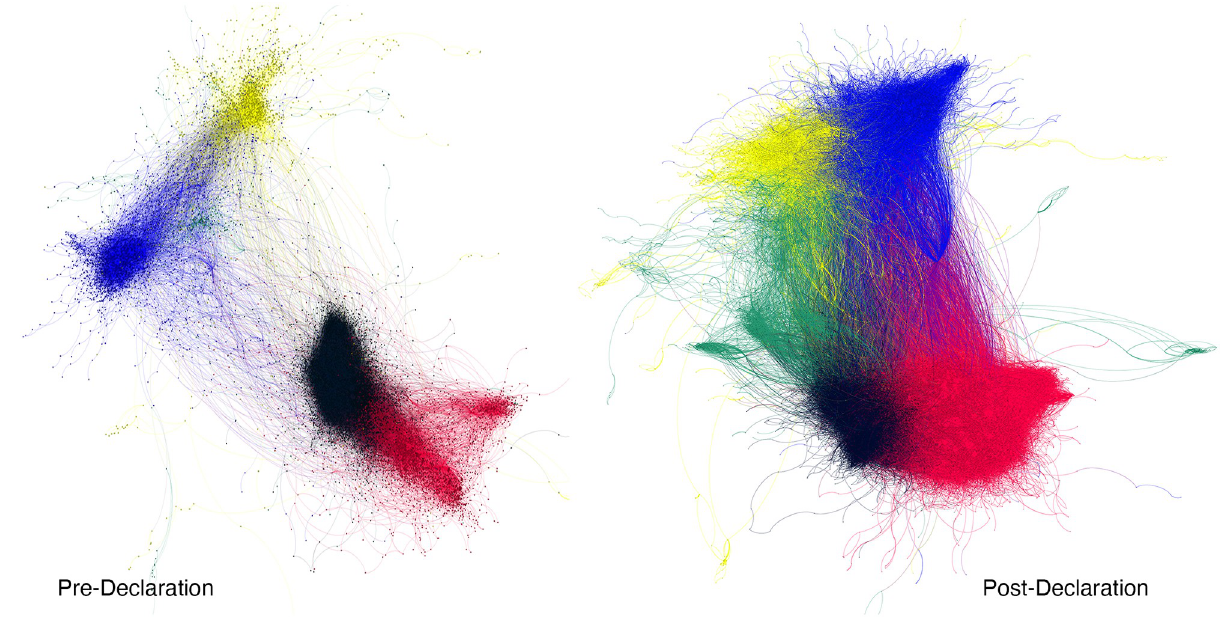
Fig 1. Visualisation of the retweet networks before and after the WHO declaration, color-coded by community.